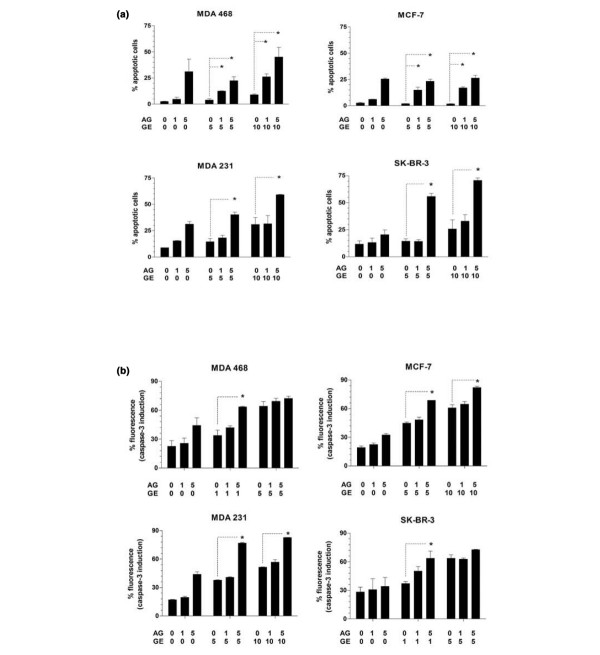
Treatment with AG1024 enhances apoptotic effects of gefitinib. (a) Flow cytometric analysis of apoptosis in cells stained with annexin V and propidium iodide after 72-hour treatment of breast cancer cells with AG1024 (AG), gefitinib (GE), or both. (b) Flow cytometric analysis of caspase-3 induction by Red-DEVD-FMK fluorescence after 24-hour treatment of cells with AG1024, gefitinib, or both. Addition of AG1024 to gefitinib treatment significantly enhanced apoptotic induction over levels achieved by gefitinib alone. Values on horizontal axes are concentrations (μM). *P < 0.05.